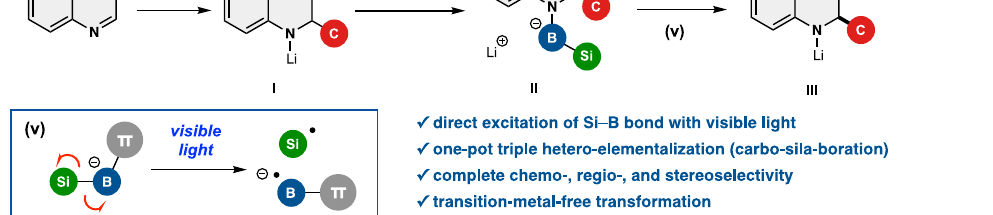
Fig. 1 | Overview of previous studies and this work. a Hydrosilylation and sila- boration of alkenes using silylborane (Si – B) via four types of Si – B bond activation. b Previous work on dearomative hydroboration, hydrosilylation, or C – Si and N – B